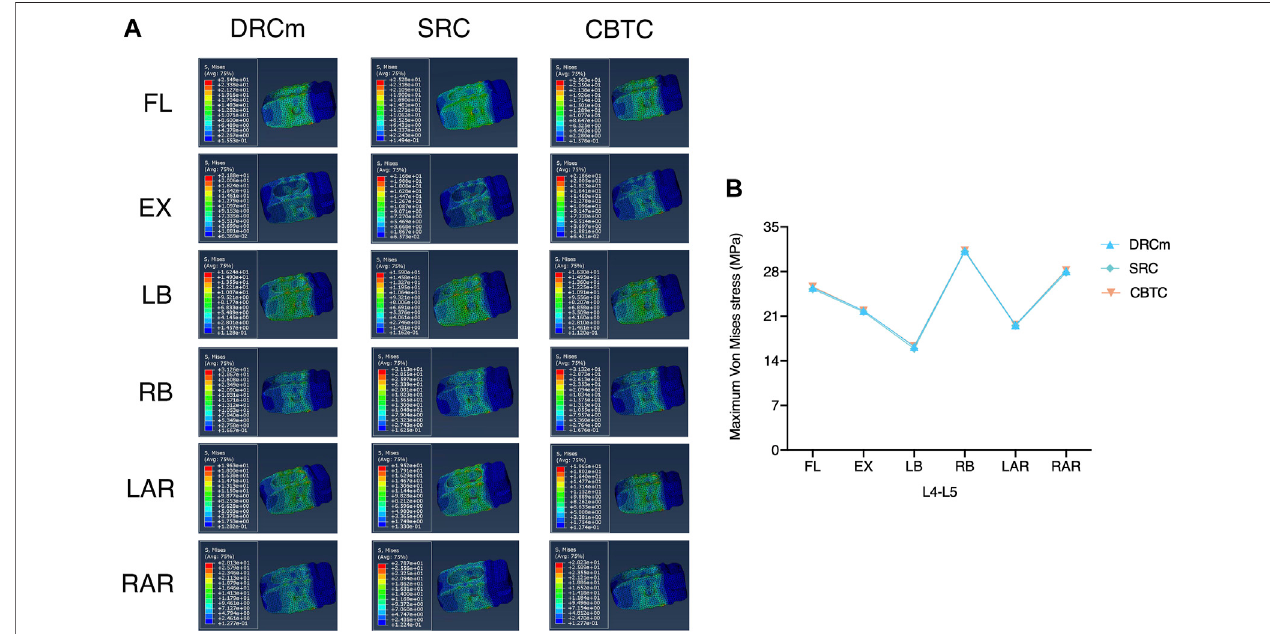
FIGURE 5 | Distribution characteristics of the maximum VMS on the cage at the previous surgical level (A) and its tendency for change among the three constructs (B) .